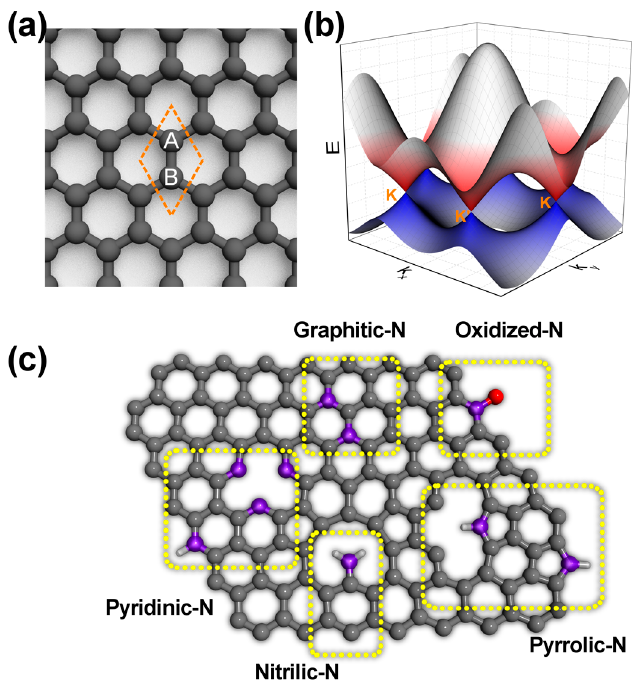
Figure 1. Basics of graphene and nitrogen doped graphene. ( a ) Atomic structure and ( b ) electronic band structure of pristine graphene. The orange diamond in ( a ) illustrates the unit cell which contains two carbon atoms on sublattices A and B. ( c ) Common nitrogen dopant configurations in graphene.